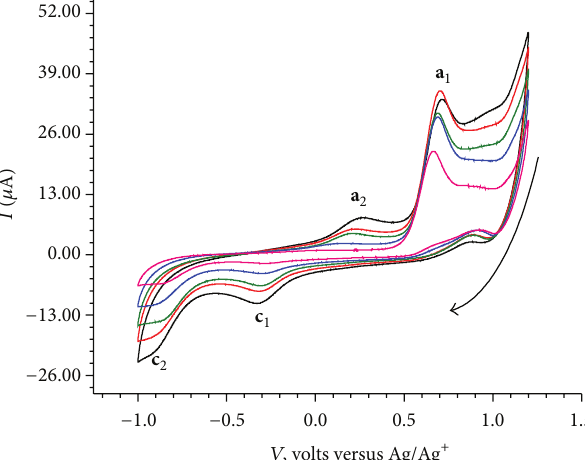
Figure 3: Cyclic voltammogram of the Betti base at increasing scan rate from 100 to